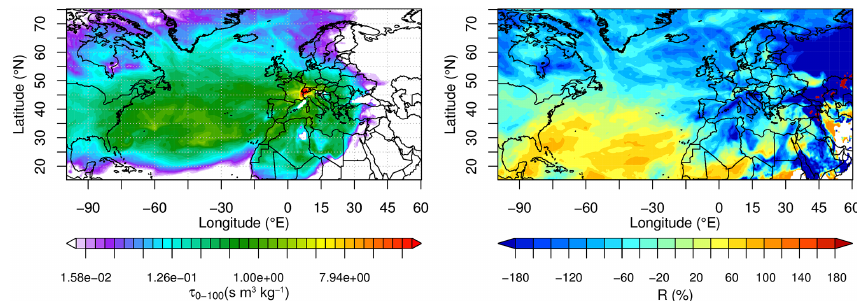
Figure 8. Combined footprint from all events with high halogen signal (IO −